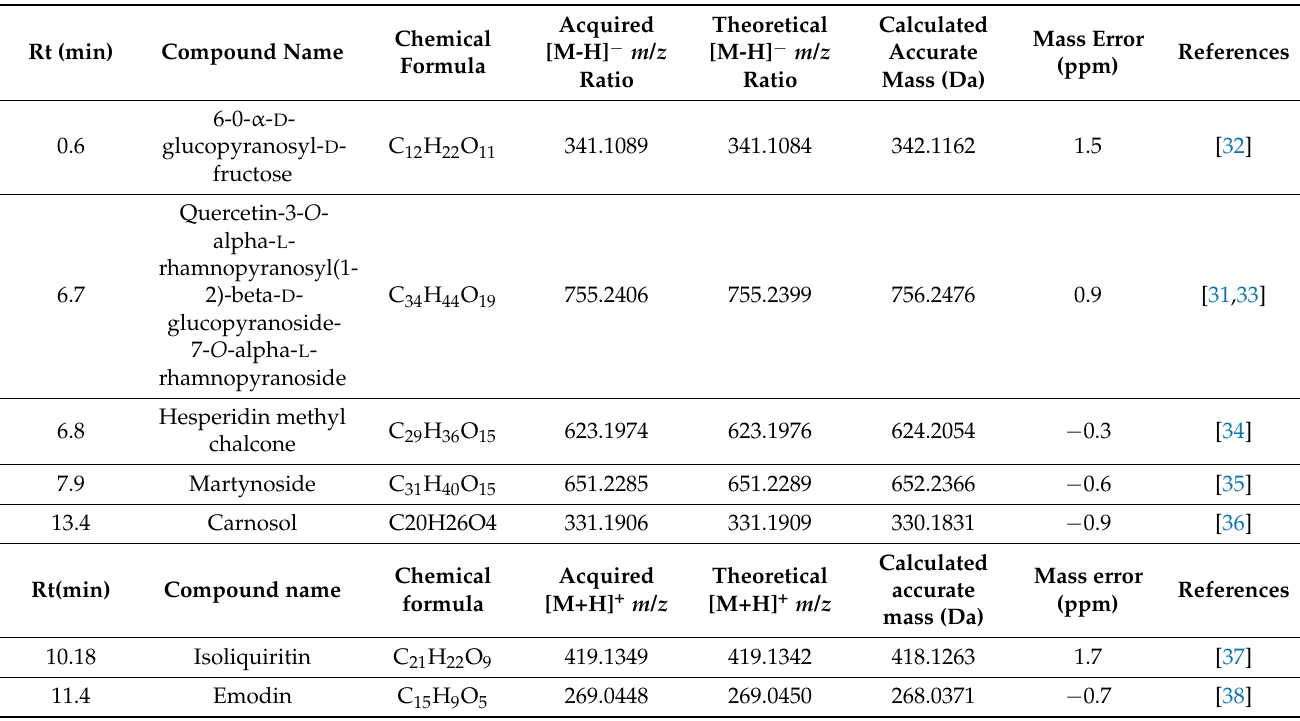
Table 1. Possible compounds tentatively identified in PHELA ® hydro-alcohol extracts using UPLC- ESI-QTOF-MS correspond to peaks as depicted in Figure 1 in both negative modes followed by positive ionization